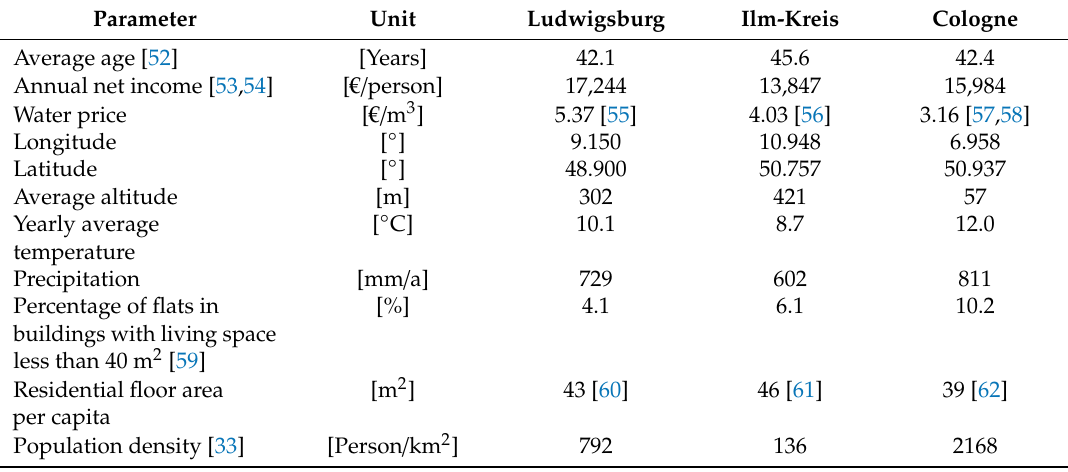
Table 6. Socio-economic and climatic data of the three German counties used for